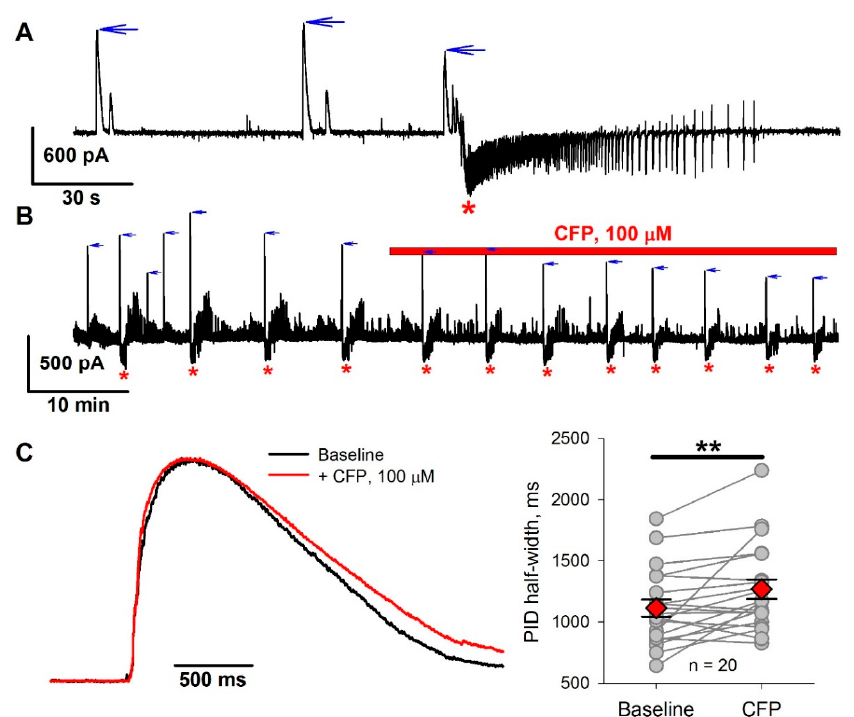
Figure 2. The effect of cefepime (CFP) in the 4-aminopyridine model. ( A ) A representative voltage clamp recording of epileptiform activity in entorhinal cortex slices. Vhold = − 27 mV, which is about halfway between the reversal potentials of glutamate- and γ -aminobutyric acid (GABA)-mediated currents. Two main types of epileptiform events can be observed: GABA-mediated preictal discharges (PIDs), which manifest themselves as positive currents at − 27 mV (blue arrows), and seizure-like events (SLEs) (red asterisks), during which both positive (GABA-mediated) and negative (glutamate-mediated) currents are observed. ( B ) A representative voltage clamp recording, illustrating the effect of bath application of CFP. Note an increase in SLE frequency and a decrease in PID amplitude after CFP administration. (C) The effect of CFP on PID duration. Left panel: normalized and averaged current, recorded during PIDs. Right panel: the graph shows changes in the PID half-width. ** p < 0.01 (paired t -test).